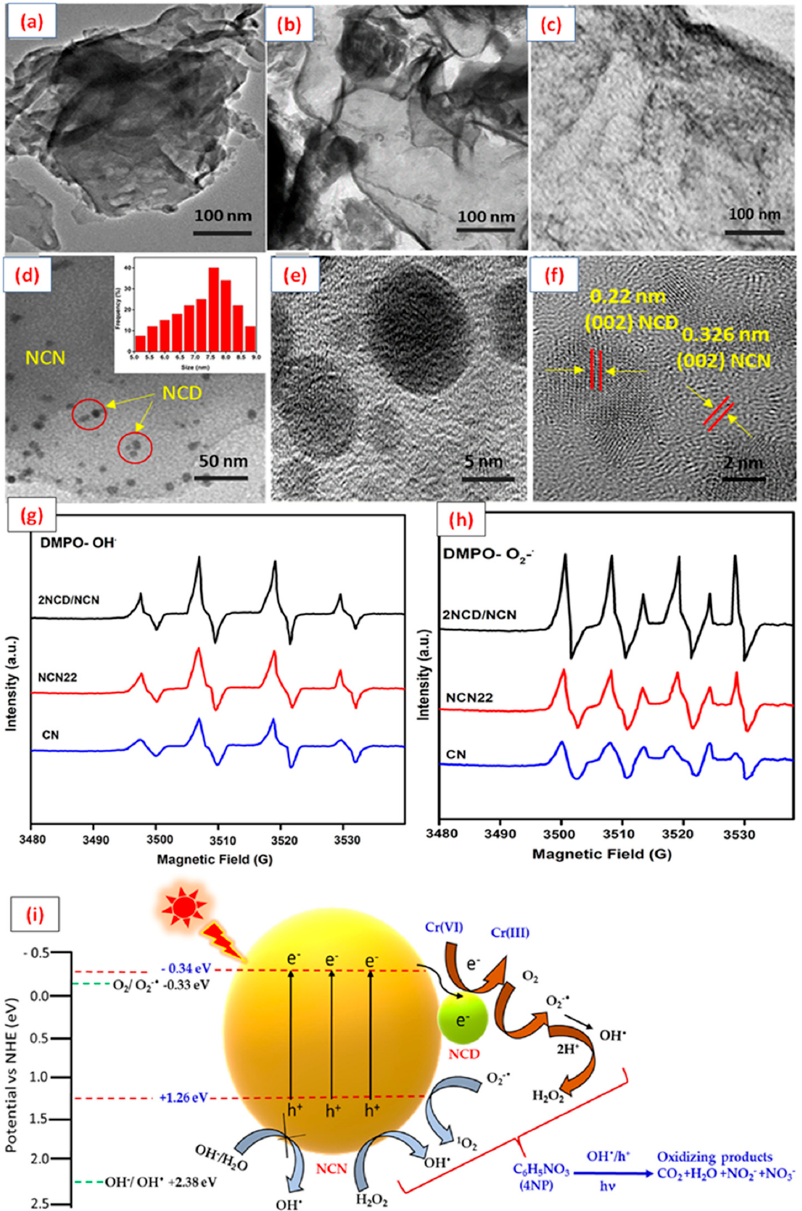
Figure 6. TEM ( a – c ) and HRTEM ( d – f ) images of CN, NCN22, and 2NCD/NCN. ESR spectra of radical adducts trapped by DMPO in C 3 N 4 , NCN22, and 2NCD/NCN under visible-light irradiation in ( g ) aqueous dispersion for DMPO-OH • and ( h ) methanol dispersion for DMPO-O 2 •− . ( i ) The proposed photocatalytic mechanism for the simultaneous degradation of 4NP and reduction of Cr(VI) under visible-light irradiation. Reproduced with permission from Elsevier